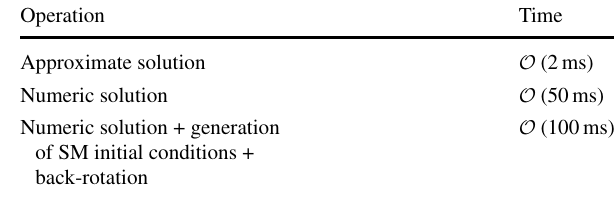
Table 10 Execution times of C++ programs that use RGESolver